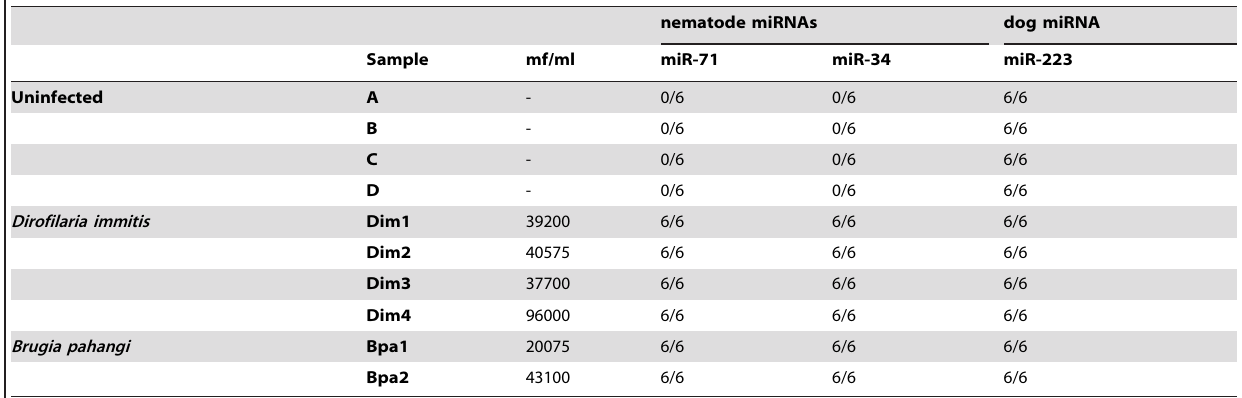
Positive detection on total reactions performed by RT-qPCR